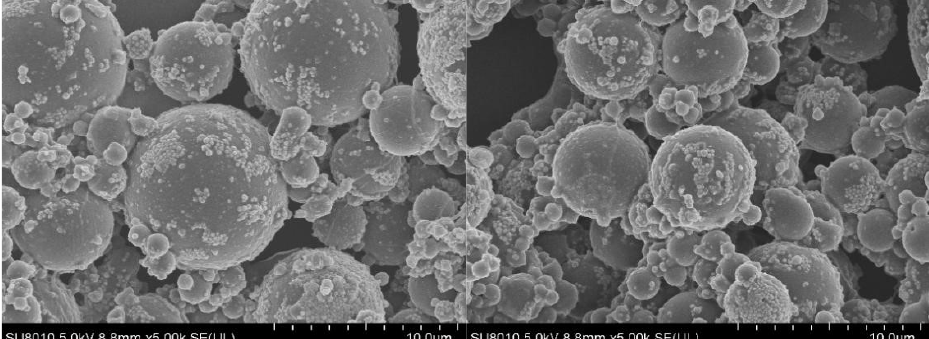
Figure 1. Scanning electron micrographs of Fe 3 O 4 @PS.